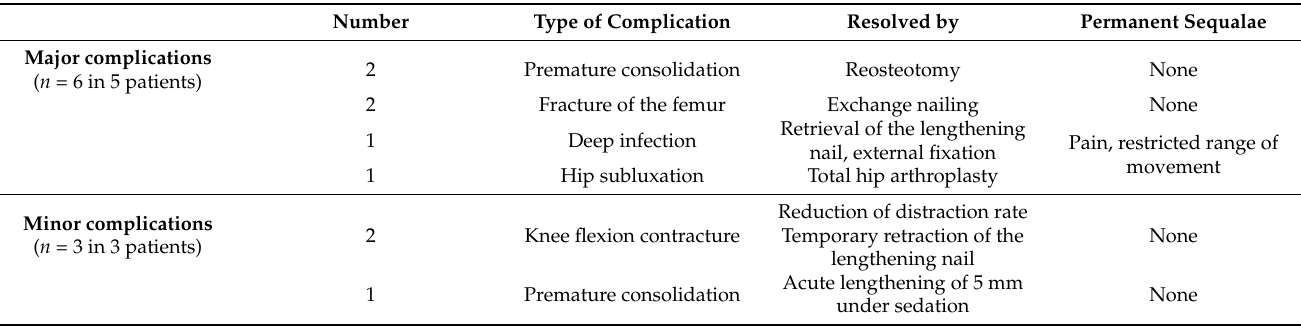
Table 5. Major complications (revision surgery and/or permanent sequalae) and minor complications (obstacles resolved without revision surgery and without permanent sequalae).